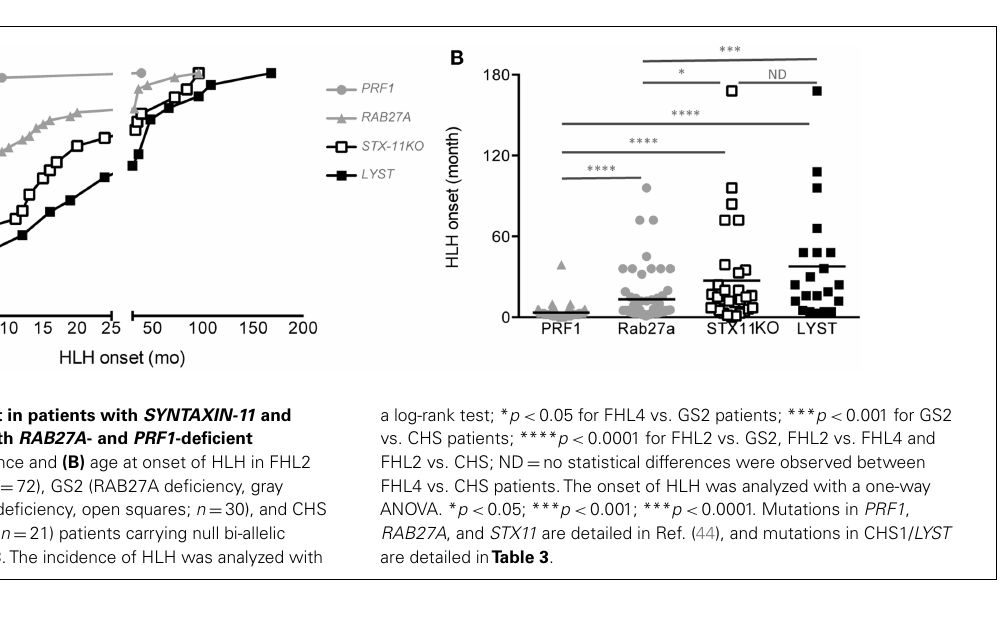
FIGURE 5 | Delayed HLH onset in patients with SYNTAXIN-11 and LYST deficiency compared with RAB27A - and PRF1 -deficient patients . (A) Cumulative incidence and (B) age at onset of HLH in FHL2 (PRF1 deficiency, gray circles; n = 72), GS2 (RAB27A deficiency, gray triangles; n = 61), FHL4 (STX11 deficiency, open squares; n = 30), and CHS (LYST deficiency, black squares; n = 21) patients carrying null bi-allelic mutations, as detailed in Table 3 .The incidence of HLH was analyzed with